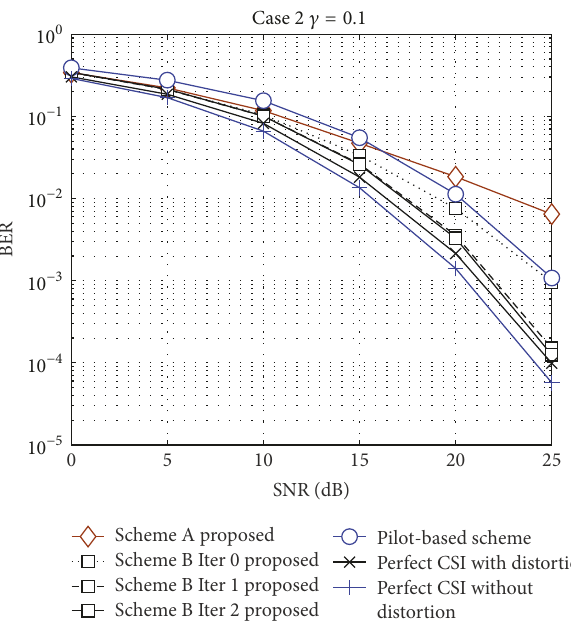
Figure 9: BER performance with different schemes for Case 2